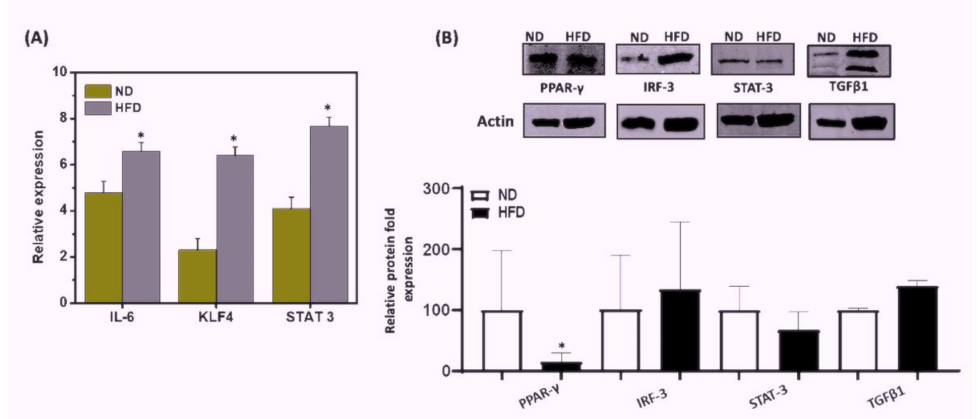
Figure 6. Effects of HFD or ND feeding on mRNA expression and protein levels in mouse AT. Mice were fed HFD or ND for 12 weeks before sacrifice, and AT was collected from each group.